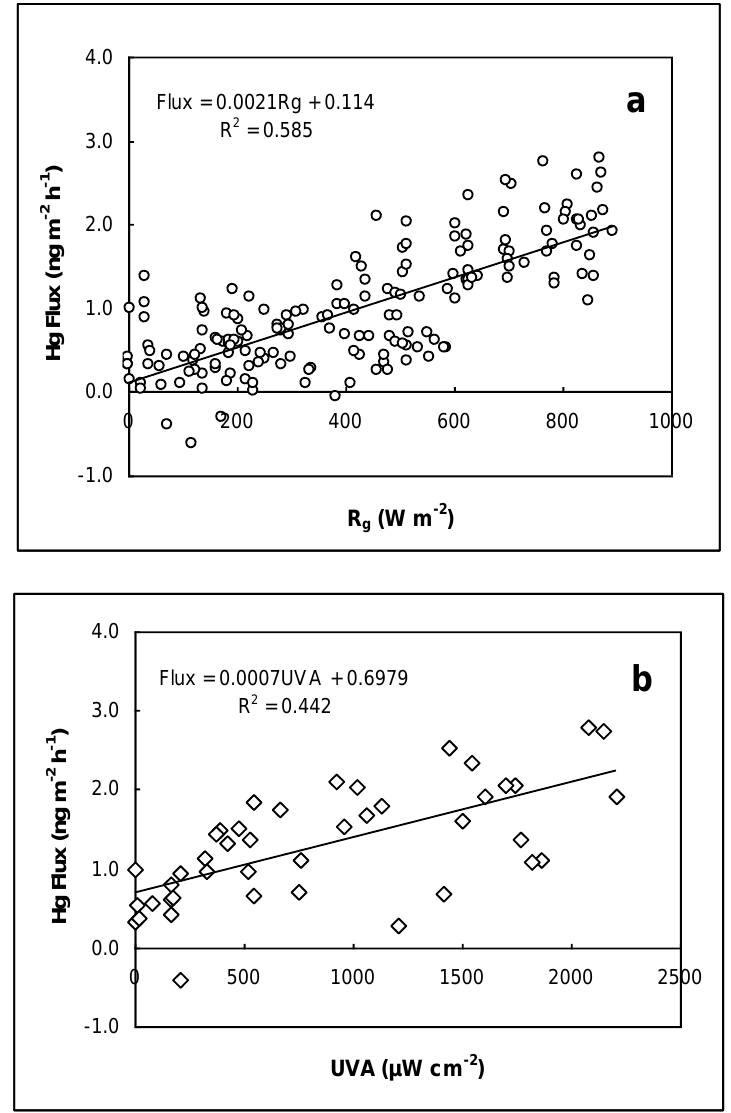
Figure 5. The relationships between all individual emission flux points versus the solar radiation data with respect to ( a ) solar radiation ( R g ) and ( b ) UVA radiation for the entire study at Cane Creek Lake (TN, USA).